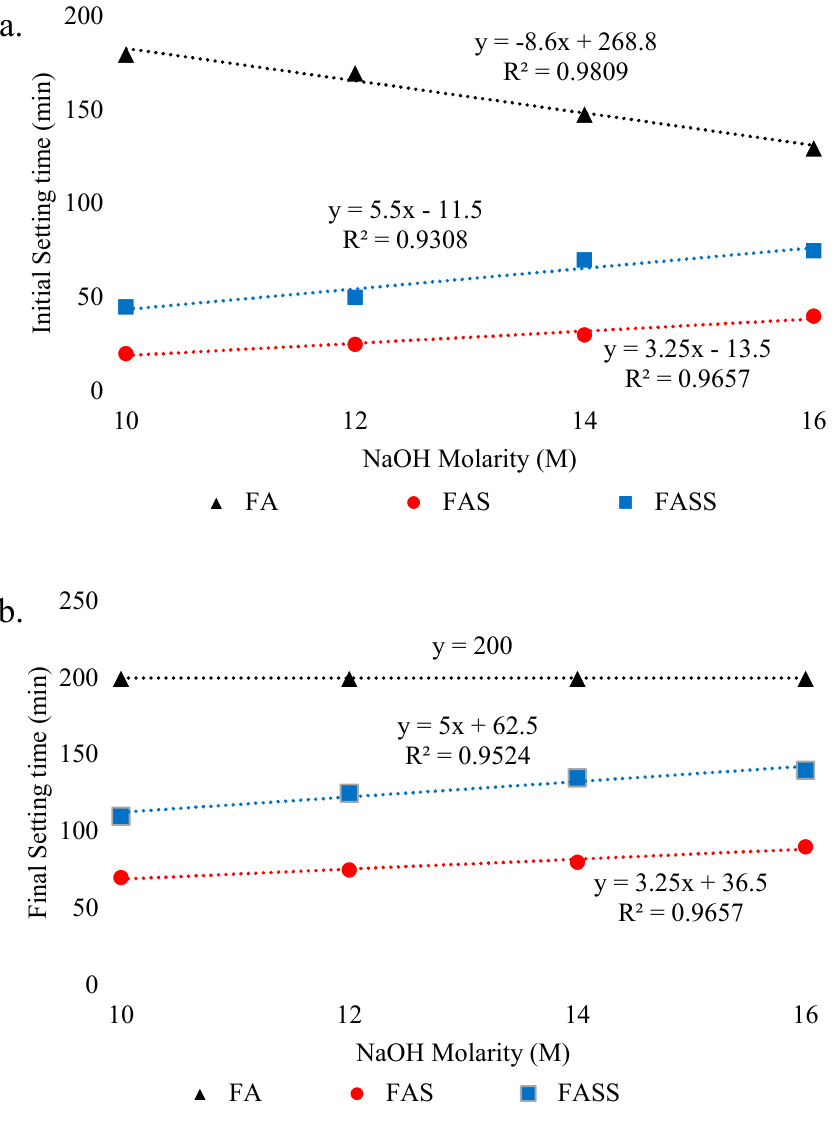
Figure 10. E ff ect of NaOH molarity on setting time of FA, FAS, and FASS-based geopolymer. ( a ) E ff ect on initial setting time, ( b ) e ff ect on final setting time, adopted from [116]; Elsevier, 2018.